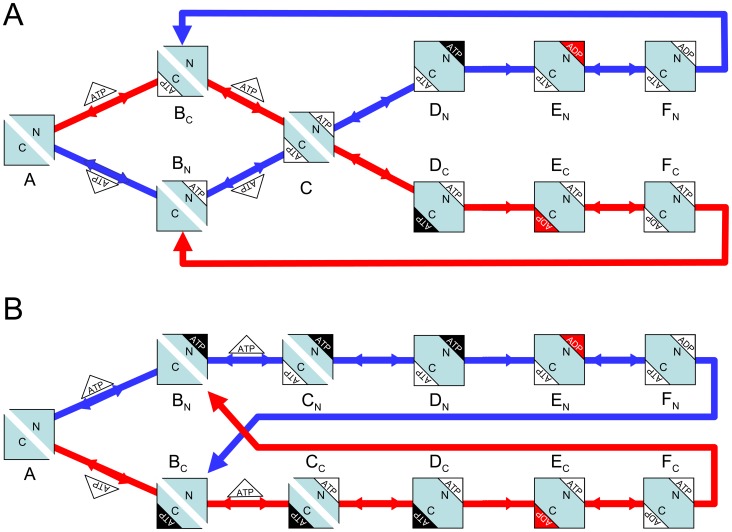
Cartoons depicting the Alternating Cycle.(A) Random binding model adapted from Urbatsch et al. [32]. (B) Sequential binding model proposed in this work (see
Figure 2
). White triangles represent ATP, black triangles represent ATP committed for hydrolysis; ADP·Pi is shown in red, ADP in white. The subscripts of the intermediates (A to F) correspond to the N and C terminal halves of the protein. Closure of the NBD dimer interface is reflected in the fusion of both halves of the protein square. Flow through each half-cycle is represented by the blue and red arrows.